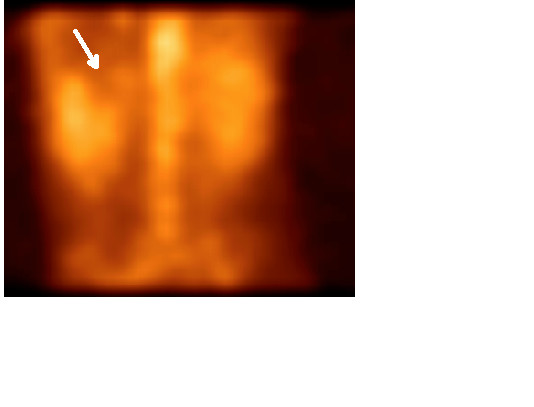
Volume-rendered Single Photon Emission-Computed Tomography image of a gallium scan demonstrating absence of tracer localization in the upper pole of the right kidney (white arrow) compatible with infarction.